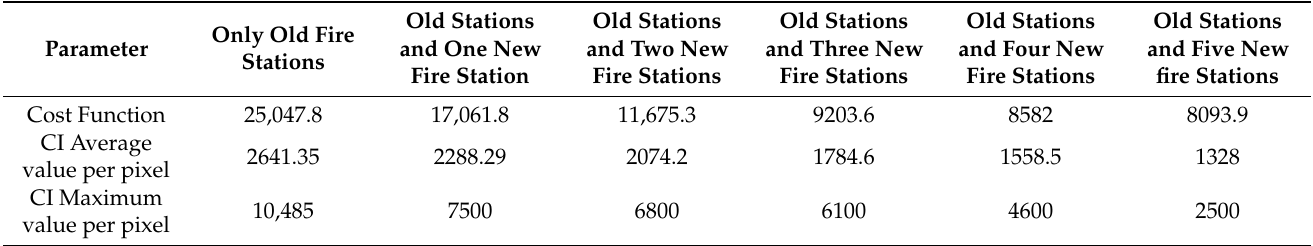
Table 4. Cost function value and average and maximum values of the collapse index per pixel in minutes for old FS and for each optimisation